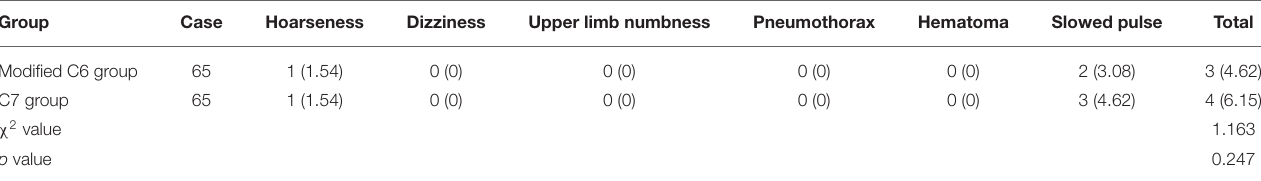
TABLE 5 | Comparison of adverse reactions between the two groups [ n (%)].